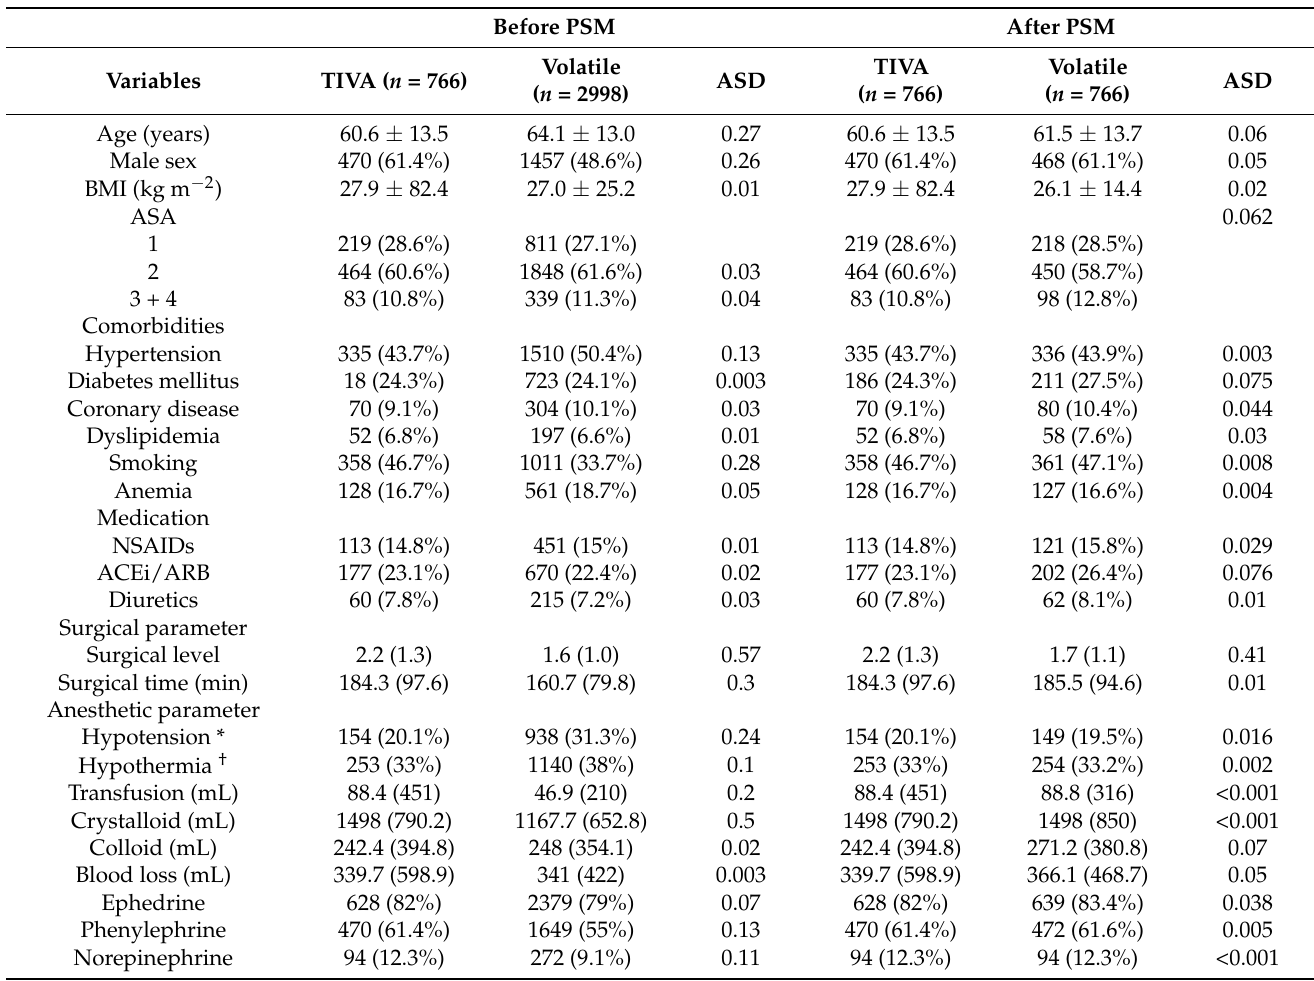
Table 1. Comparison between TIVA (total intravenous anesthesia) group and volatile anesthesia group for baseline characteristics before and after propensity score matching (PSM).